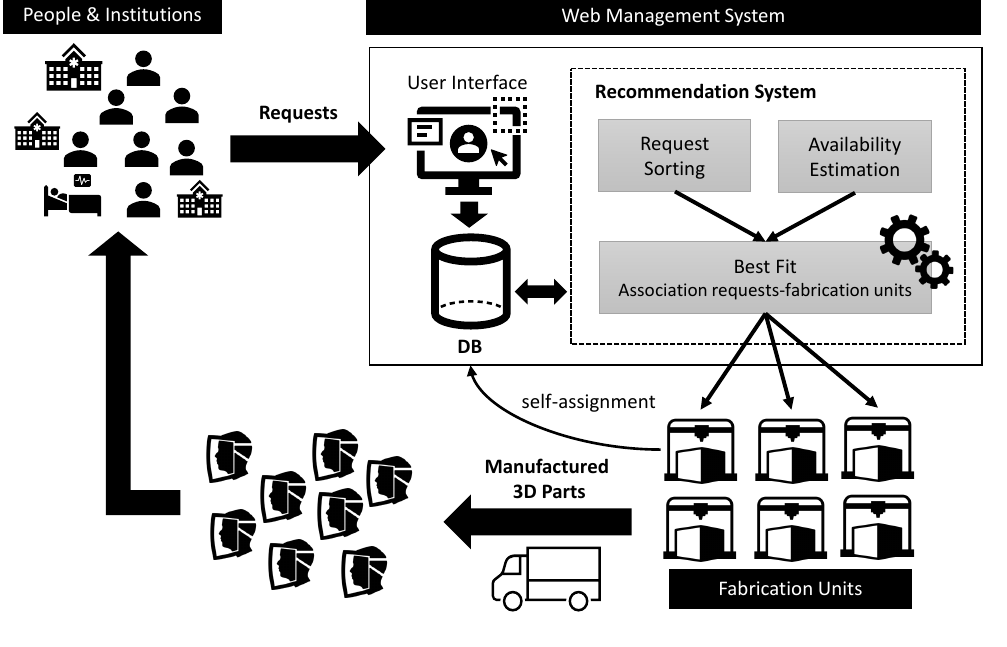
Figure 4. General scheme of the designed and developed